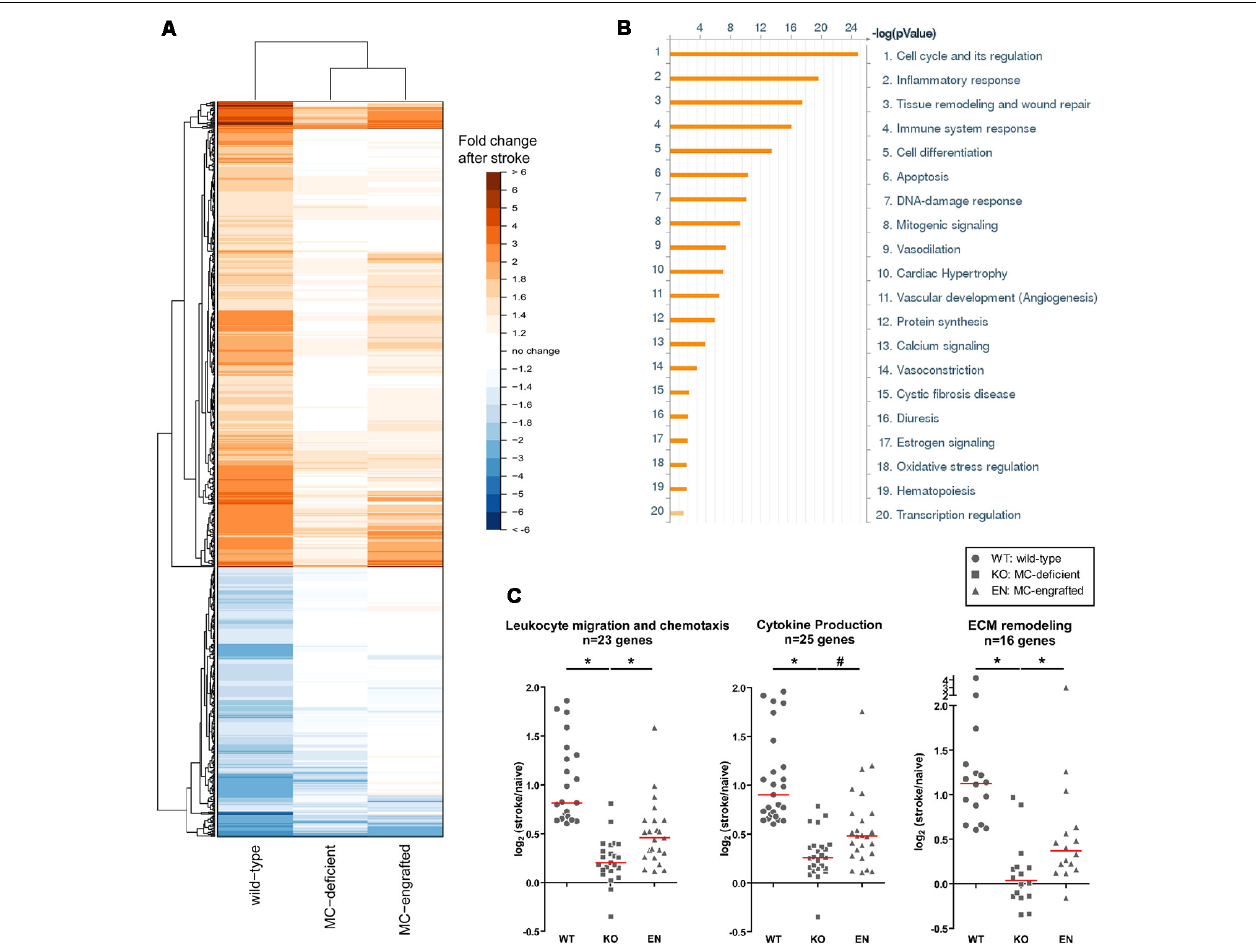
FIGURE 3 | Meningeal gene expression changes after stroke. (A) Heatmap showing the fold-change in expression of genes significantly changed ( p < 0.05) after stroke in WT (WBB6F 1 - Kit + / + ) mice with the corresponding change in expression in MC-deficient (WBB6F 1 - Kit W / W-v ) and MC-engrafted [WBB6F 1 - Kit W / W-v mice which had been engrafted in the meninges with WT bone marrow-derived, cultured MCs (BMCMCs)] mice (irrespective of whether the gene changes in these two groups after stroke reach significance). The genes represented are those with an absolute fold-change after stroke of ≥ 1.5 in WT mice. (B) Pathway map of the functional grouping of genes that were significantly upregulated after stroke in WT mice. (C) Dot plots showing the log 2 fold-change in expression after stroke of genes within the indicated gene ontology groups in each of three mouse groups. The genes represented in each gene ontology group were significantly upregulated after stroke in WT mice, with a fold-change of ≥ 1.5. Each data point within a mouse group represents a different gene. Red line indicates median. ∗ p < 0.05; # p =